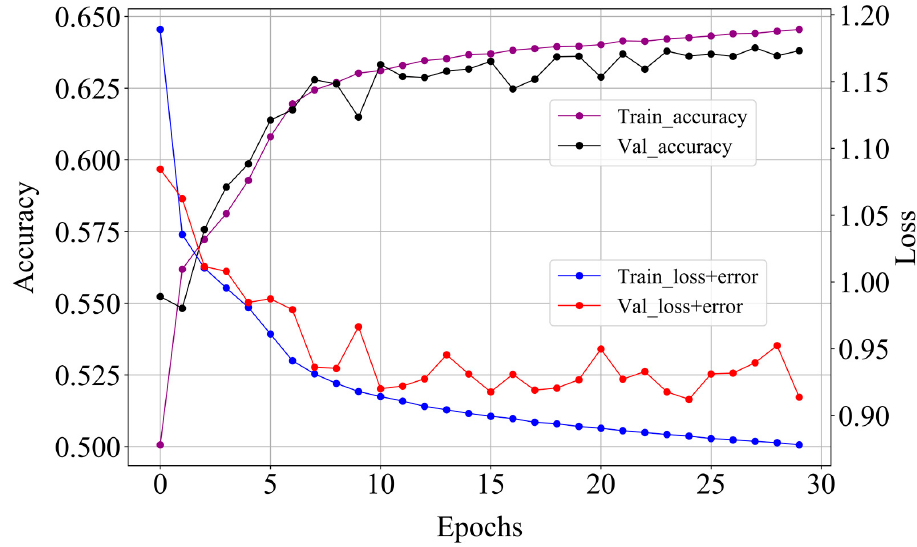
Figure 8. Relation curve of loss value, accuracy, and number of iterations.